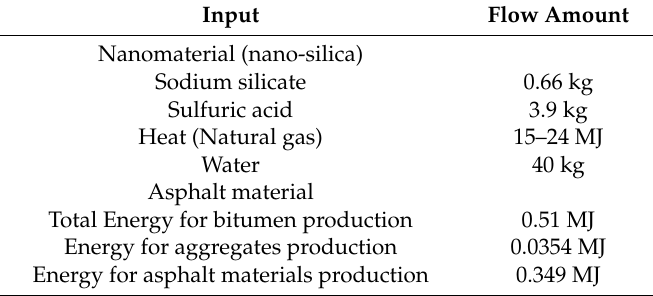
Table 2. Materials and energy requirements for 1 kg unit production of nano-silica and asphalt